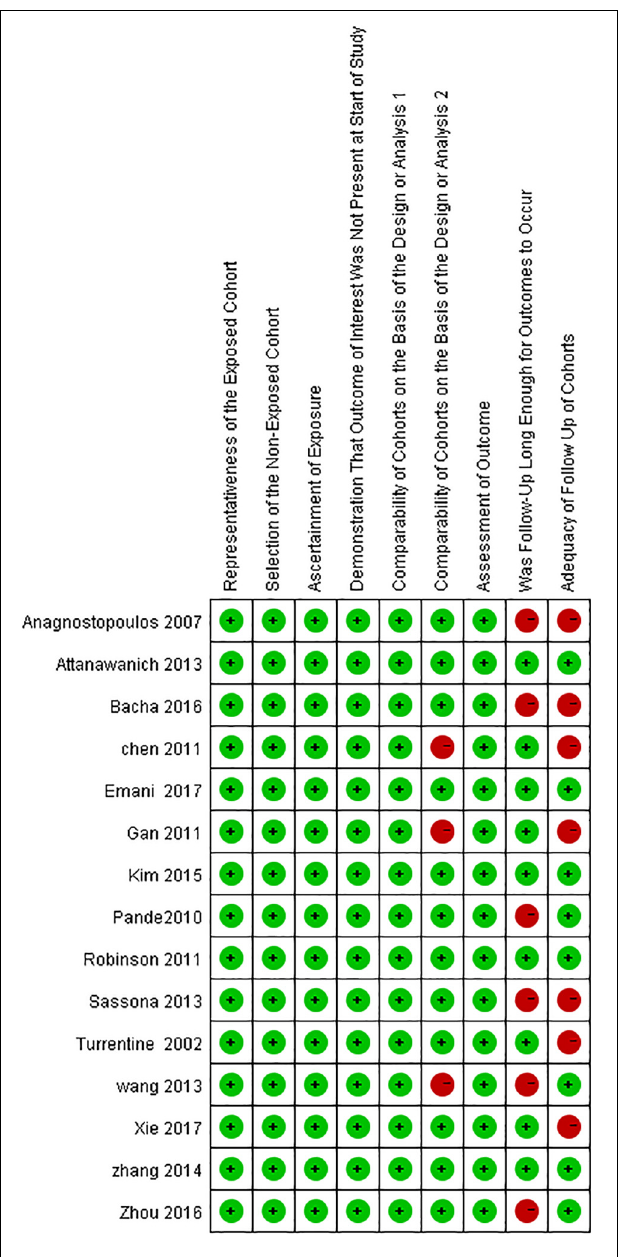
FIGURE 2 | Assessment of the risk of bias for each included